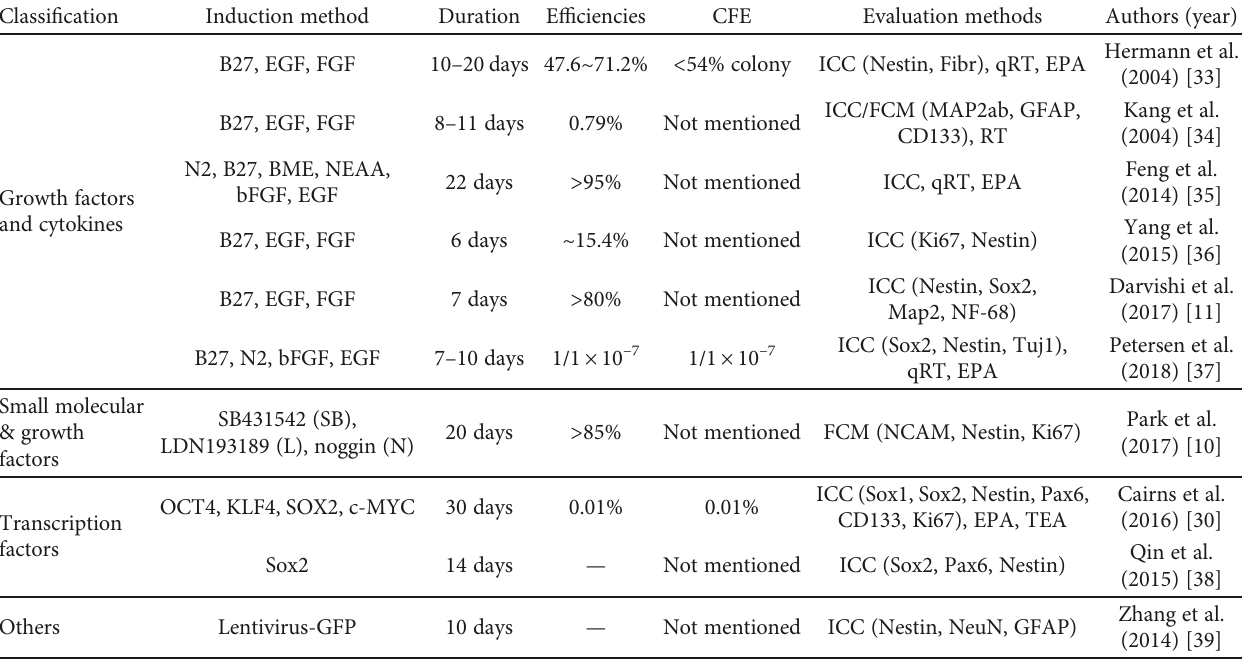
Table 1: List of transdi ff erentiation e ffi ciency of ADSCs into